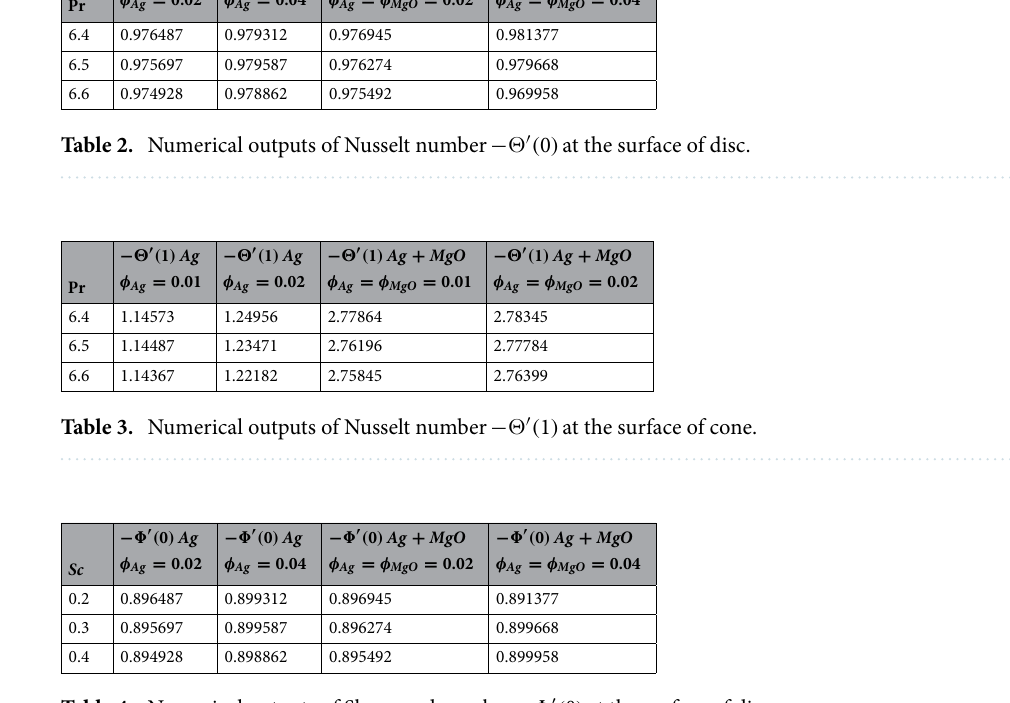
Table 4. Numerical outputs of Sherwood number − � ′ ( 0 ) at the surface of